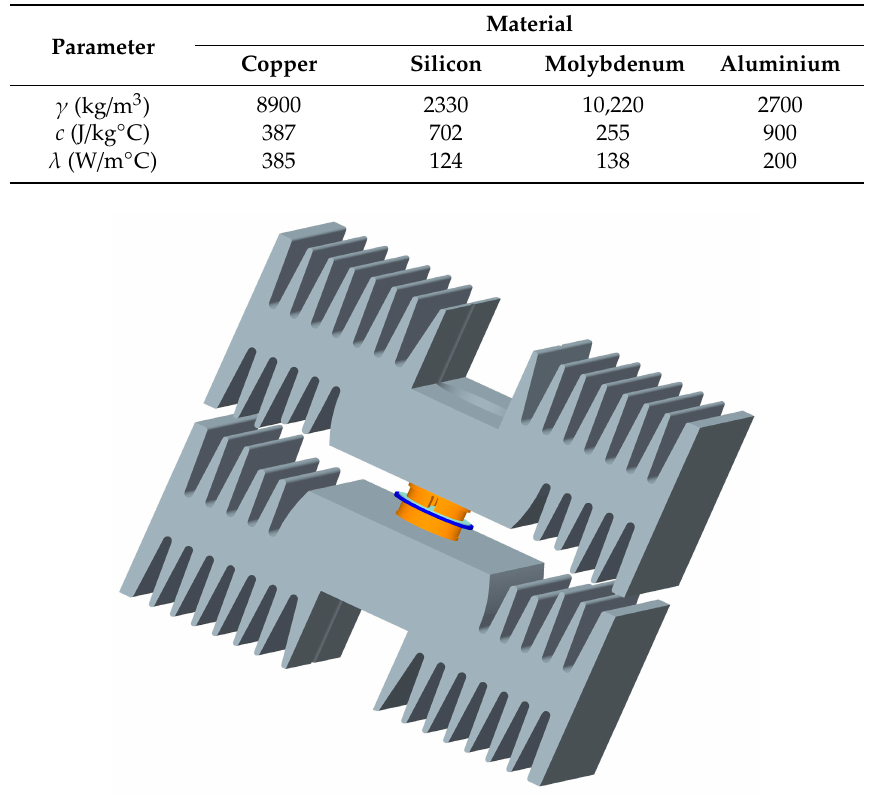
Table 1. Material data.